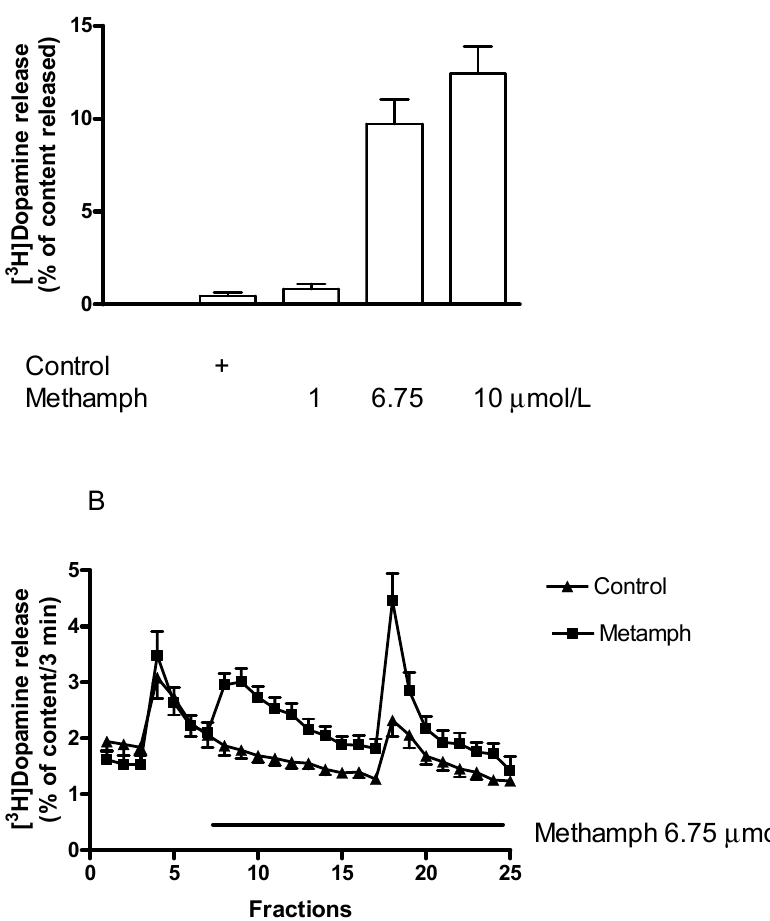
Figure 4. A ( ± )Methamphetamine (methamph) increased both non-vesicular and vesicular [ 3 H]dopamine release from rat striatum. For the experimental procedure, see Figure 2A,B. ( A ) The releasing effect of ( ± )methamphetamine on resting [ 3 H]dopamine efflux was concentration-dependent in a range of 1 to 10 µ mol/L. The estimated concentration of ( ± )methamphetamine that increased resting [ 3 H]dopamine release by 50% above control release was 3.2 µ mol/L. One-way ANOVA followed by the Dunnett’s test, F(3,20) = 35.14, p < 0.001, ( ± )methamphetamine in 6.75 and 10 µ mol/L concentrations significantly increased non-vesicular [ 3 H]dopamine release, p < 0.01, mean ± S.E.M., n = 4-8. ( B ) (±)Methamphetamine was added to striatal slices from fraction 8 in a concentration of 6.75 µmol/L and maintained throughout the experiment. Resting [ 3 H]dopamine release (defined as frac- tional release between fractions 8 and 17) was 0.37 ± 0.08 in control and 4.27 ± 0.46 percent of the